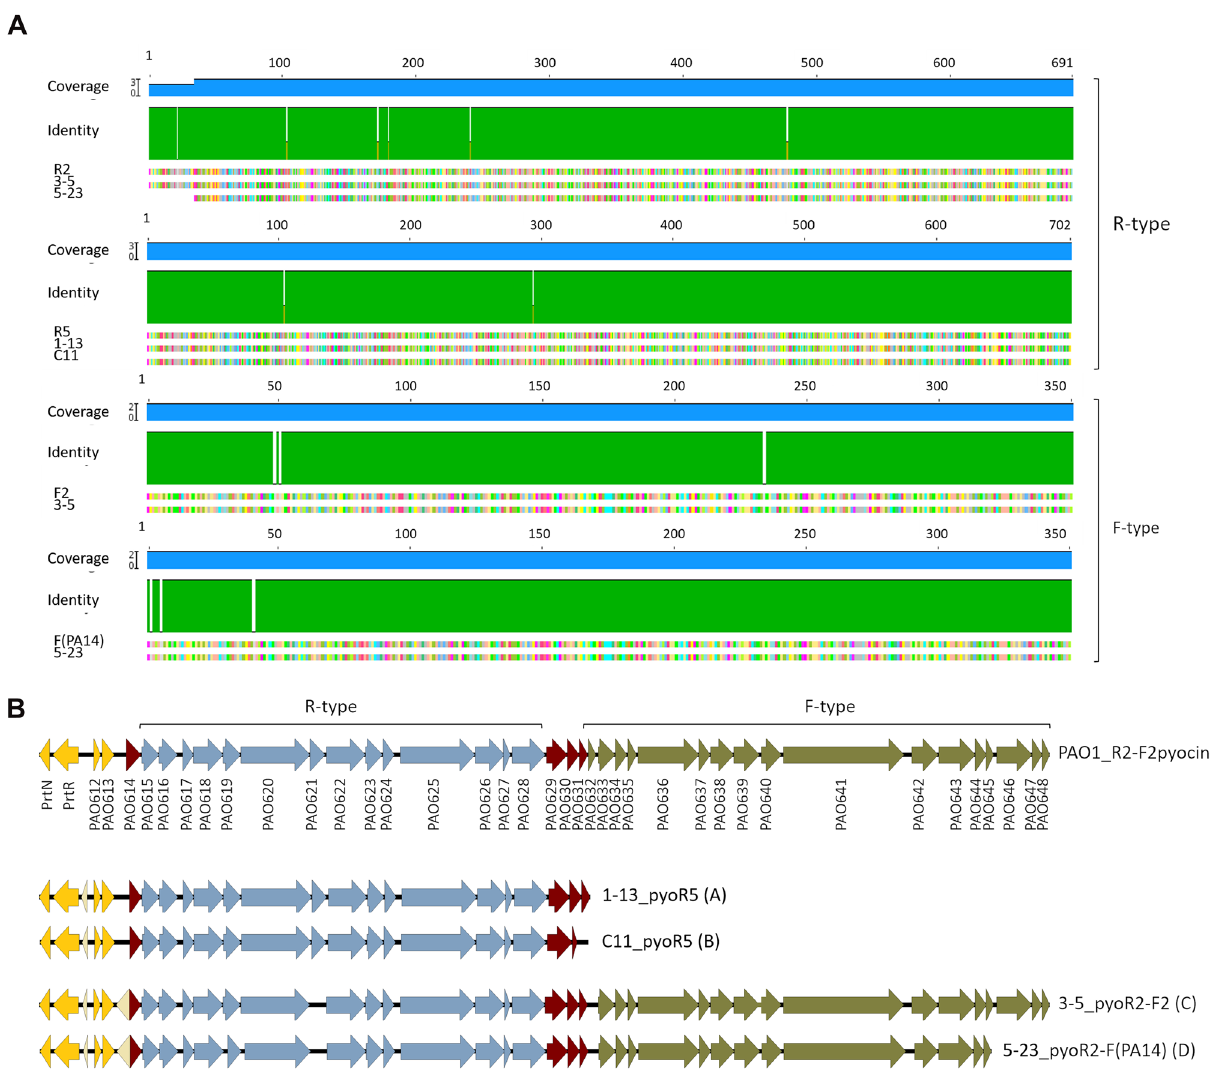
Figure 1. Identification of the pyocin subgroup. ( A ) Homology comparison of the tail fiber protein model sequence of R2, R5, F2 and F(PA14) with one representative of each pyocin type identified in this study. ( B ) Structure of the pyocin cluster of one representative of each group (A, B, C and D), and comparison with the reference pyocin R2-F2 from P. aeruginosa PAO1. Yellow: regulatory genes; red: lysis cassette; blue: R-type pyocin cluster genes, brown: F-type pyocin cluster genes. The representative sequences were selected by numerical order due to the high intragroup